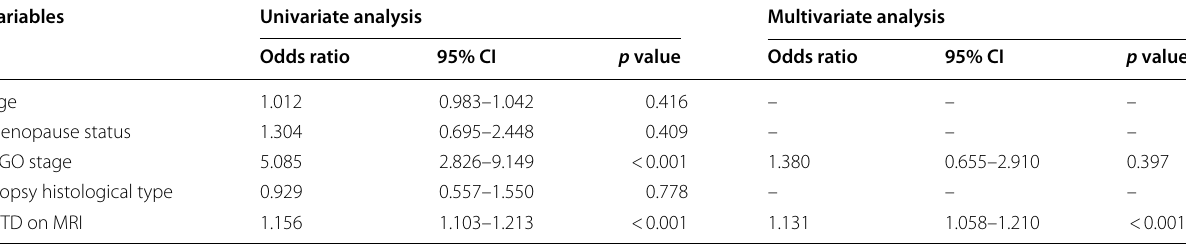
FIGO, Federation International of Gynecology and Obstetrics; CI, confidence interval; MTD, maximal tumor diameter